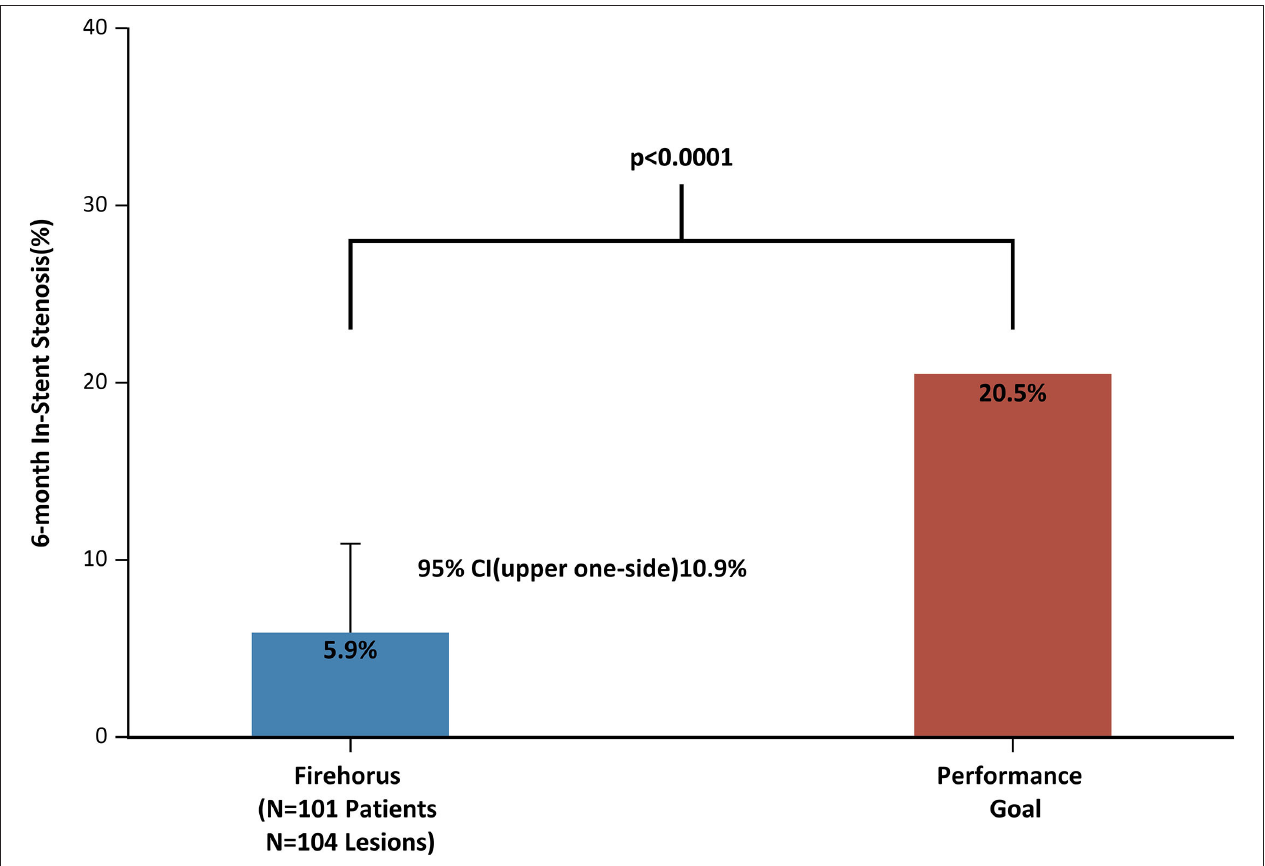
FIGURE 5 | Prespecified performance goal and primary